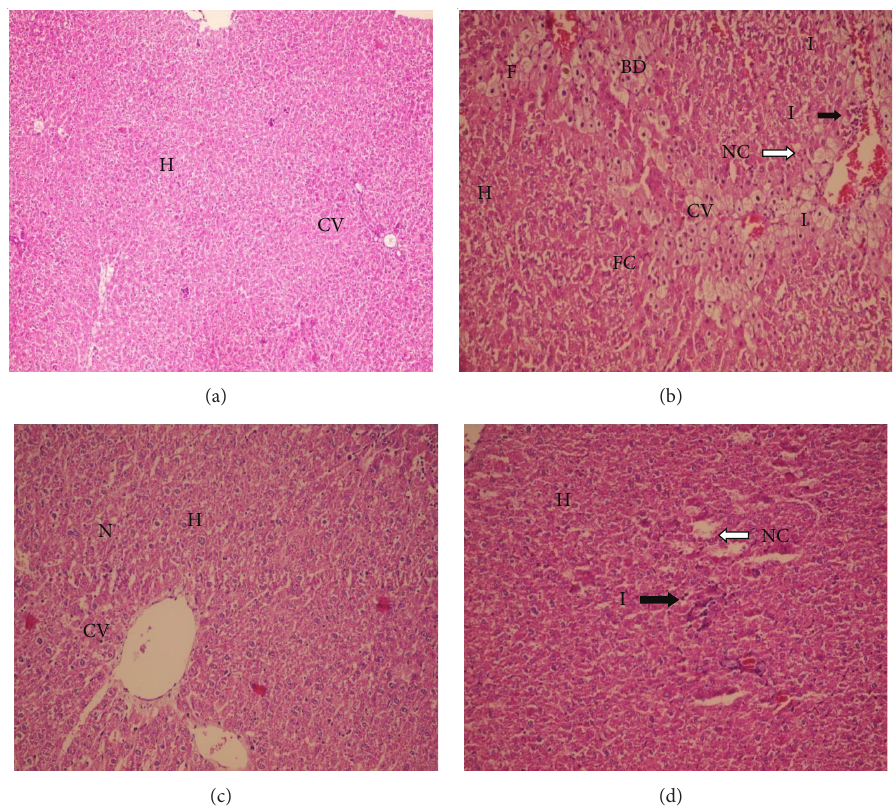
Figure 1: Effect of the platelet-rich plasma (PRP) on histopathological changes induced by CCl 4 in rats. (a) (H&E × 100) liver section of normal rats showing normal hepatocytes with prominent nucleus, cytoplasm, and central vein; (b) (H&E × 250) liver sections of CCl 4 - treated (0.5mL/kg i.p.) rats showing fatty chain, necrosis, and infiltration of inflammatory cells; (c) (H&E × 250) liver sections of the rats treated with PRP (0.5 mL/kgs.c.) showing well-brought out central vein hepatocytes with well-preserved cytoplasm and normal hepatocytes with prominent nucleus; (d) (H&E × 250) liver sections of the rats treated with CCl 4 + PRP (0.5mL/kg + 0.5 mL/kg s.c.) showing normal architecture of hepatocytes and mild infiltration of inflammatory cells. H: hepatocyte, CV: central vein, N: nucleus, F: foamy macrophage cells, FC: fatty chain, NC: necrosis, I: infiltration of inflammatory cells, and BD: ballooning degeneration. in rats. Table 1: Effect of the platelet-rich plasma (PRP) on histopathological liver damages induced by CCl 4 Groups Ballooning Degeneration Fatty change Hepatocyte necrosis